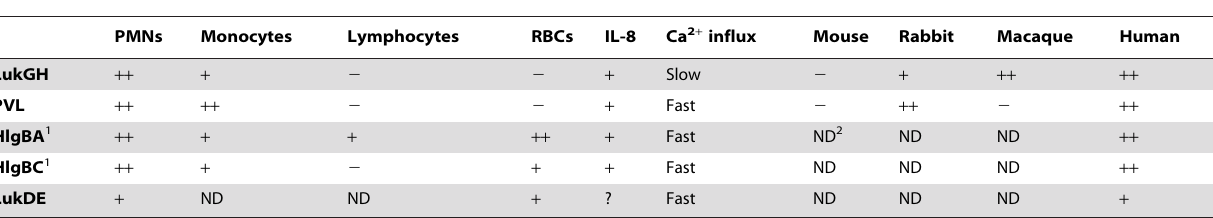
Table 3. Effects of the staphylococcal bicomponent leukotoxins